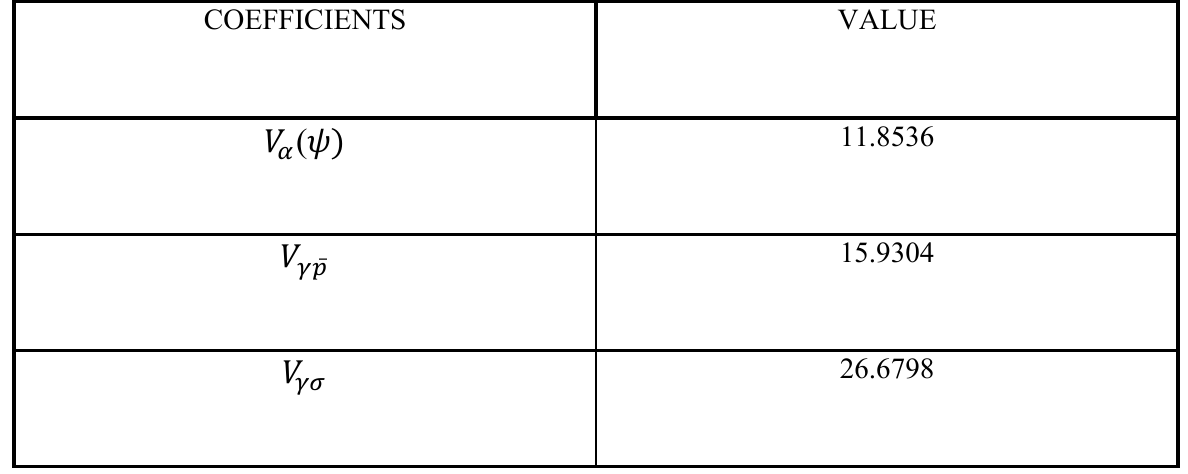
Table 1. Estimation Results for